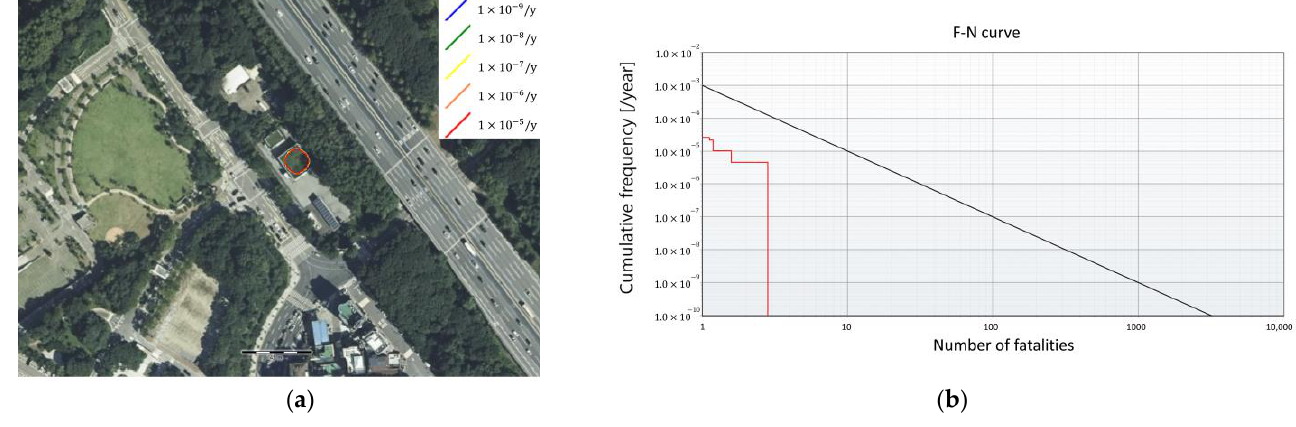
Figure 7. Risk assessment results for the FAHRS system. ( a ) The risk analysis results and ( b ) the F-N curve.